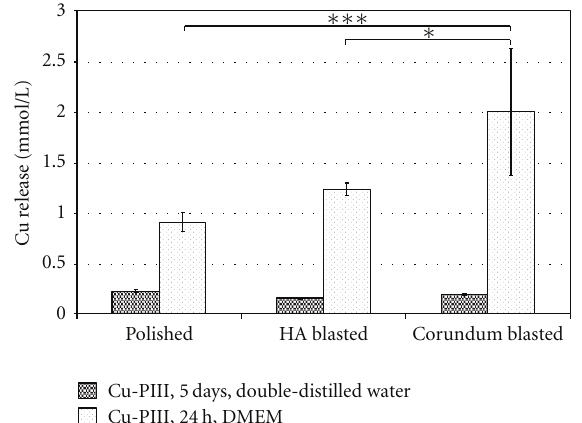
Figure 2: Copper concentration of Cu-PIII-treated Ti6Al4V sam- ples with varying substrate surface roughness (polished, HA blasted, corundum blasted), submersed for 5days in double-distilled water and 24 h in DMEM at 37 ◦ C and 5% CO 2 . ANOVA (Post Hoc LSD) test, ∗ P < 0 . 05, ∗∗∗ P ≤ 0 .